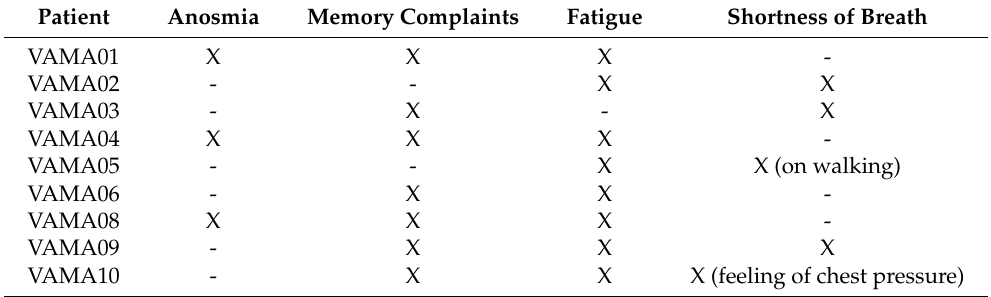
Table 4. Post-COVID-19 symptoms.